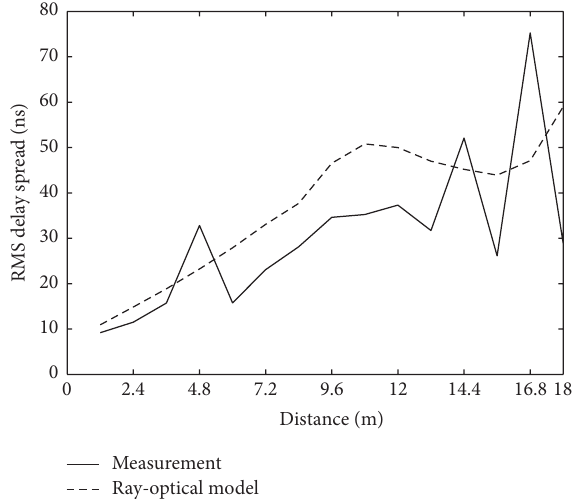
Figure 8: RMS delay spread versus link distance derived from ray- optical model and measurement on floor 2.